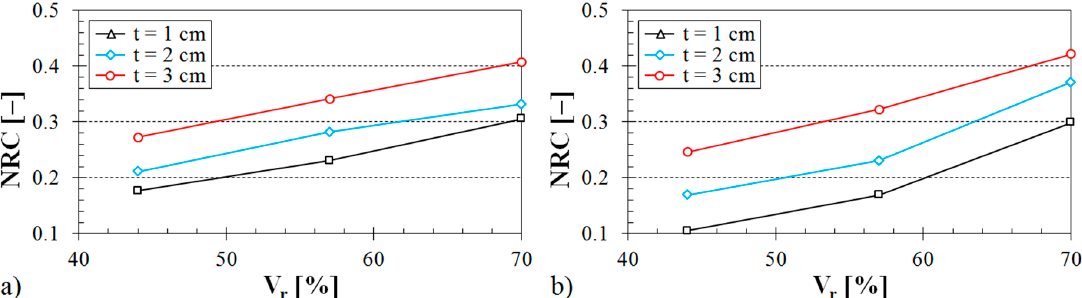
Figure 16. Influence of the sample thickness on the noise reduction coefficient vs. volume ratio for the investigated ABS samples: ( a ) Cartesian structure, air space size a = 8 cm; ( b ) Octagonal structure, air space size a = 12 cm.